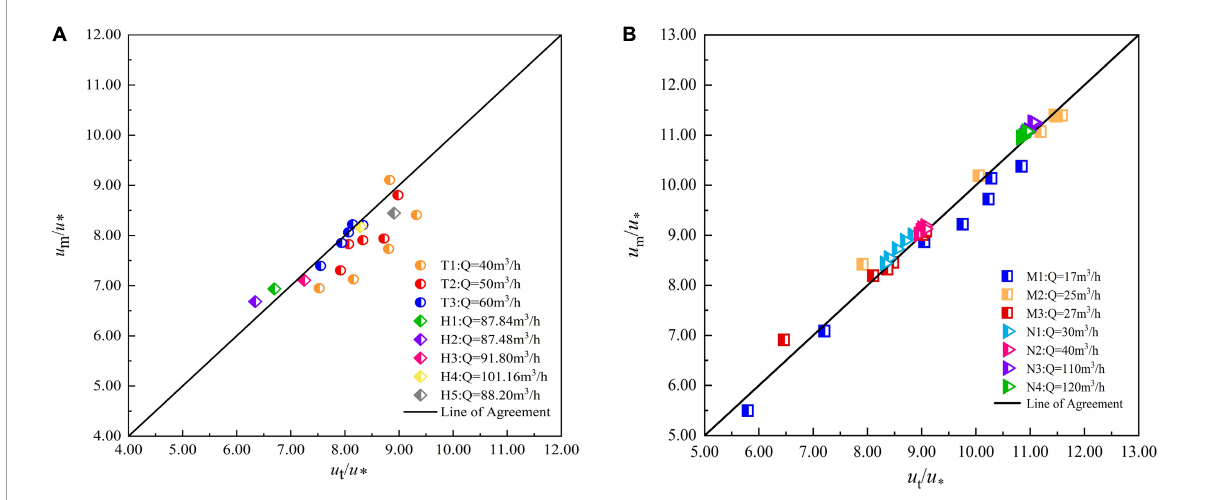
FIGURE8 Comparison between the experimental and theoretical values of the mean velocity in the arc-bottom trapezoidal channel. (A) vegetated channel, (B) smooth channel.